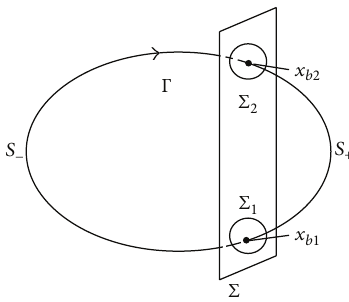
Figure 4: The two-dimensional periodic orbit and the Poincare